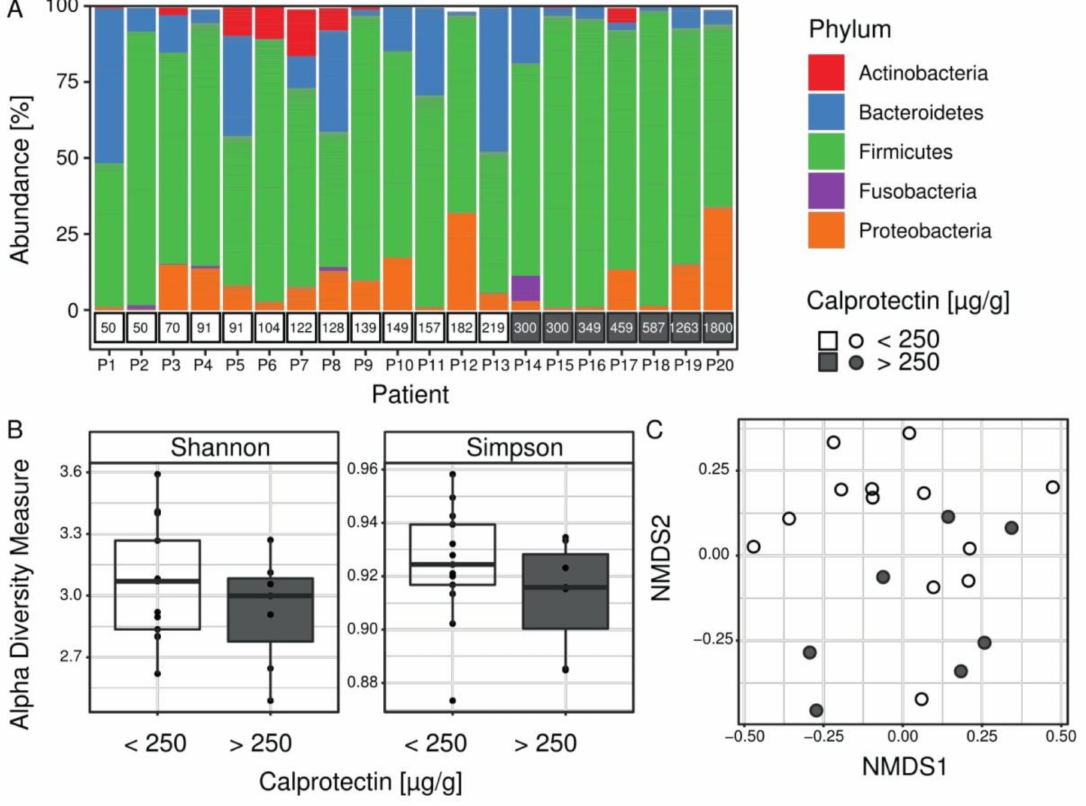
Figure 1. Microbiota composition in the Cystic Fibrosis (CF) cohort . ( A ) Proportions of bacteria from the five most abundant phyla colored according to the legend. Calprotectin measurements per patient are shown in boxes below the bar plot. The proportion of Firmicutes was significantly higher in microbiota profiles of children with intestinal inflammation (gray boxes). ( B ) Alpha diversity values for all patients ( n = 20) are shown as points and summarized as boxplots for each group. Both Shannon and Simpson alpha indices measure microbial diversity within sample, and they were not significantly di ff erent between children with and without intestinal inflammation (Wilcoxon—Mann–Whitney test). ( C ) Beta diversity (NMDS), which assesses di ff erences in microbial composition between samples